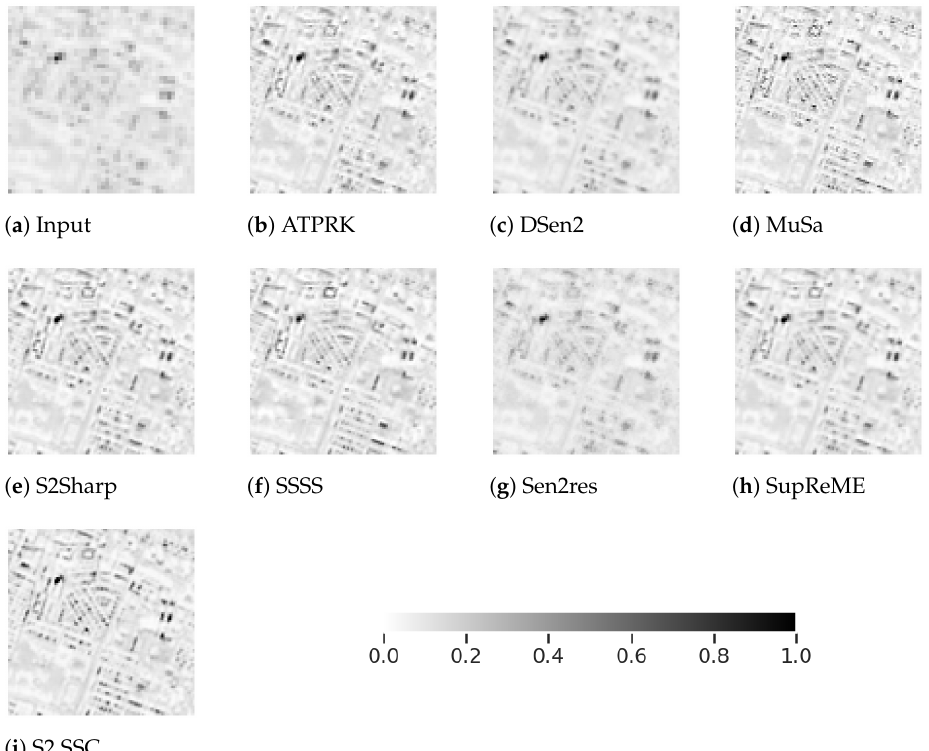
Figure 5. Band B12 of real S2 image of Reykjavik super-resolved to 10m resolution. For the 60 m B9 in Figure 4, ATPRK, S2Sharp, and SSSS appear to give comparatively good results. Rooftop outlines and street layouts are easily discernable and the image contrast looks natural. SupReME, DSen2 and Sen2res, are each successively blurrier and Sen2res returns much lower reflectance values than all the other methods resulting in much lower contrast. MuSA appears oversharpened with overbright outlier pixels. The methods all give fairly similar results for most of the 20 m bands but struggle with band B12 in particular. Building shapes are harder to discern and appear irregular compared to